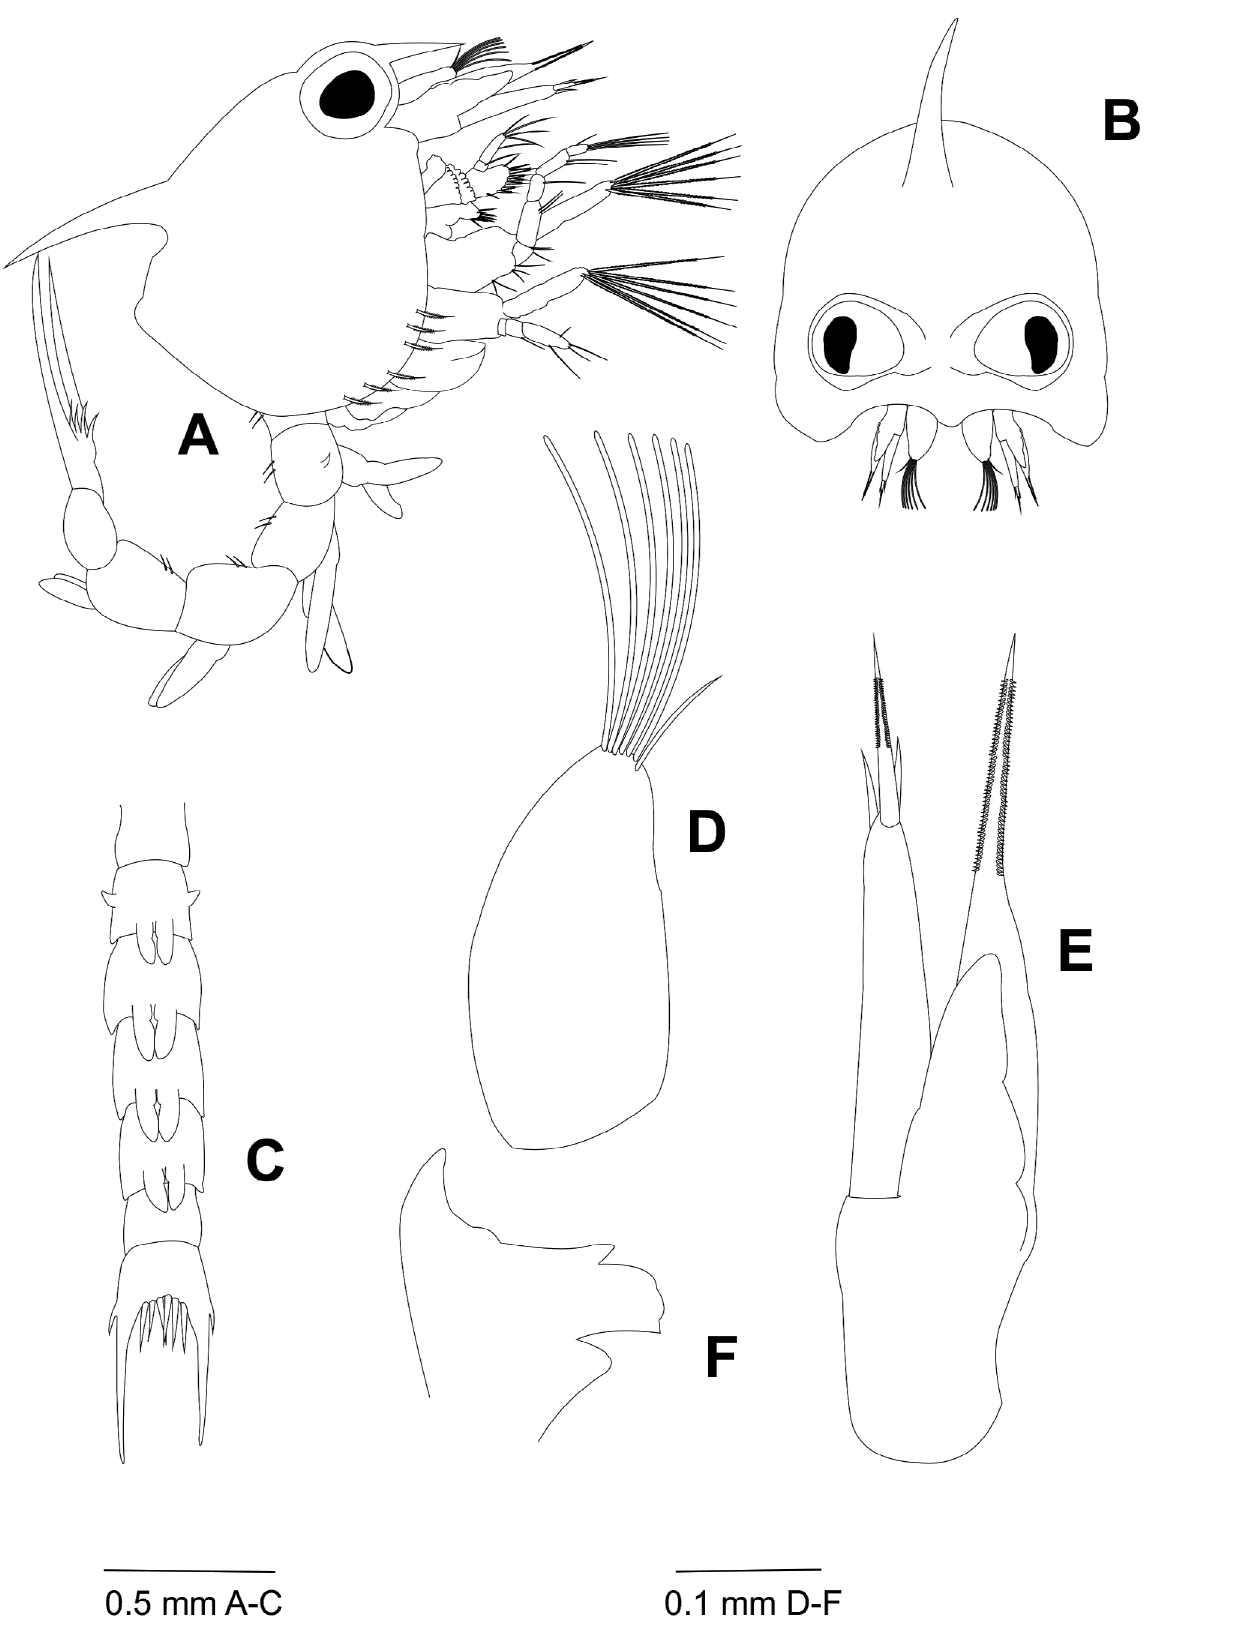
Figure 3. Libinia rhomboidea second zoea. ( A ) Dorsal view; ( B ) cephalothorax front view; ( C ) pleon; ( D ) antennule; ( E ) antenna; ( F )